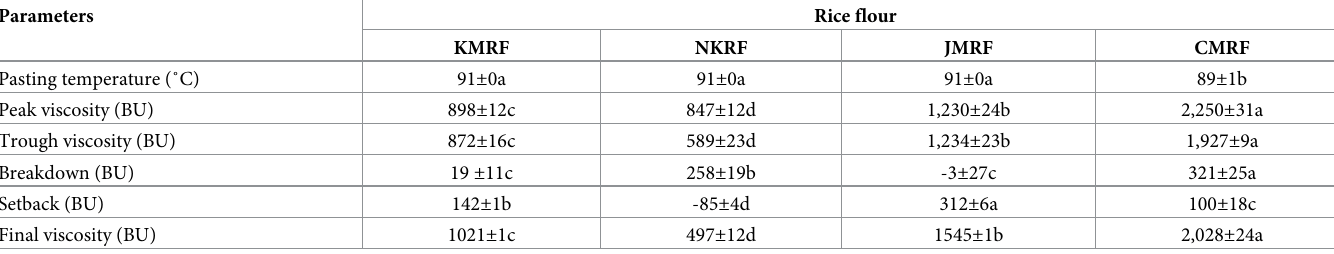
Setback (BU) Final viscosity (BU) Values are means ± standard deviation from triplicate determinations. Different letters are significantly different along the rows ( p <